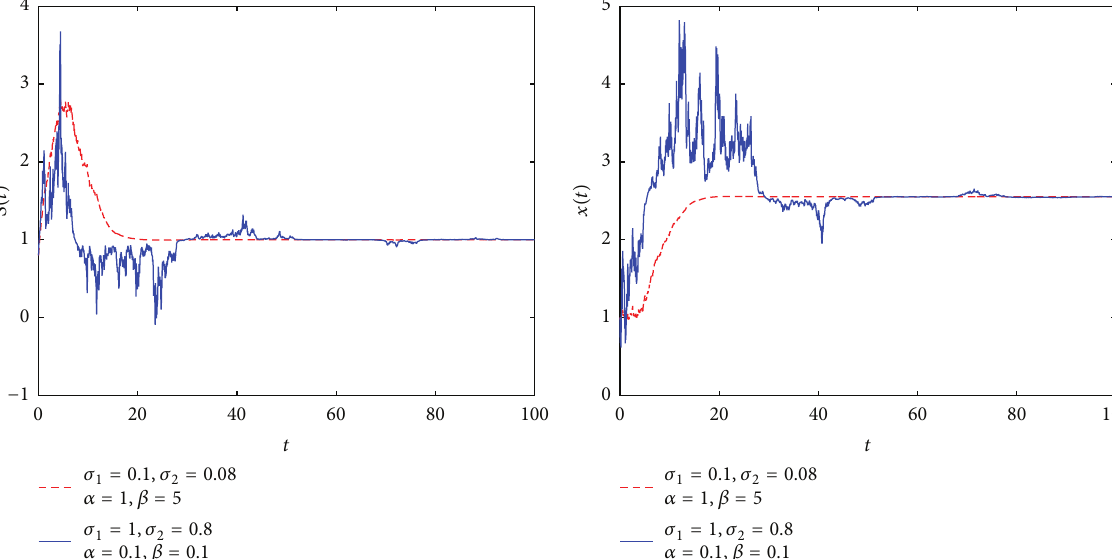
process of nutrient recycling and the growth response of the species are immediate and, therefore, 𝑇 𝑓 = 𝑇 𝑔 = 0 . Example 1 verifies the results obtained in Theorem